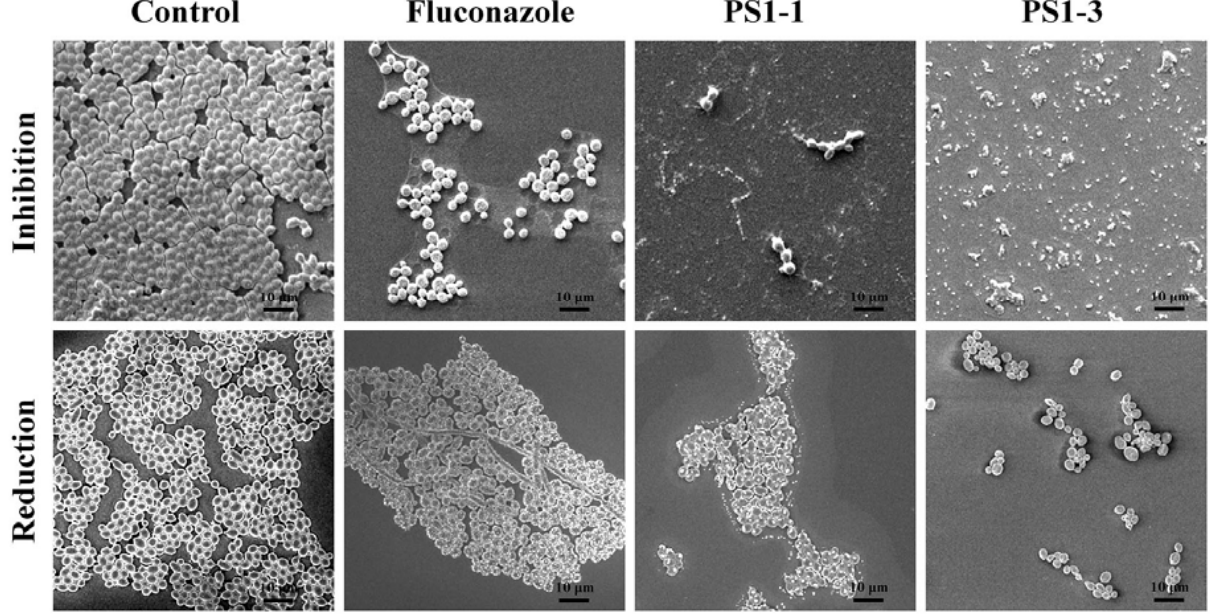
Figure 6. Image analysis of C. albicans CCARM 14007 strain using scanning electron microscopy (SEM). The biofilm inhibition and reduction on C. albicans CCARM 14007 biofilms in the absence (control) or presence of Fluconazole, PS1-1, and PS1-3 were investigated. Fluconazole, PS1-1, and PS1-3 were treated with MFC for 24 and 48 h. All values represent three individual experiments. The bar is 10 μ m.